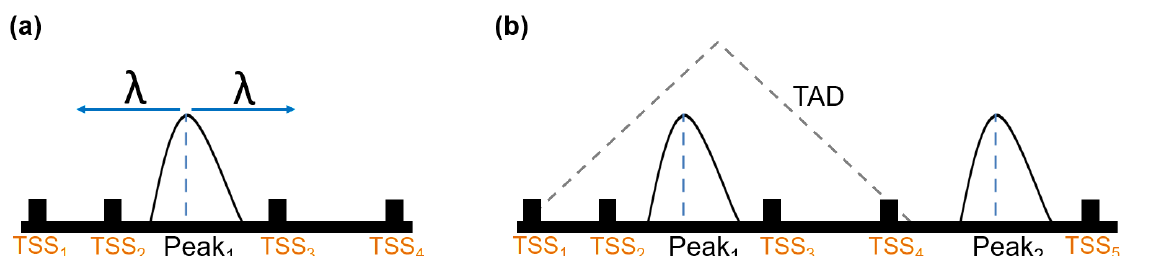
Figure 1. Cartoon showing peak expansion and overlapping TSSs in PEGS, with a specified genomic distance λ from the centre of the peak in both directions ( a ) where TSS and TSS are included, and a TAD overlapping with the left peak in ( b ) where all four TSSs within the TAD 2 3 are